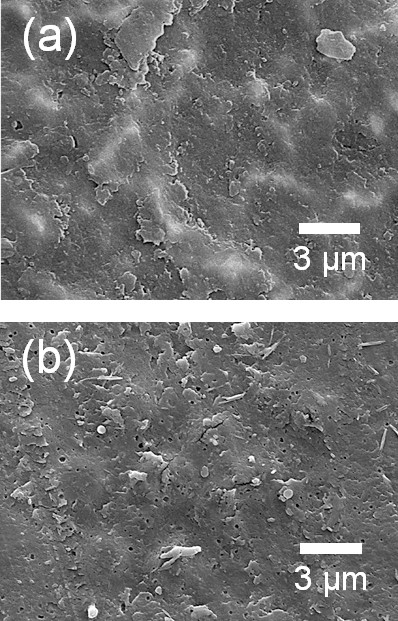
Surface SEM images of the (a) Al2O3-PMMA (30 vol.%) composite films and (b) PMMA films.